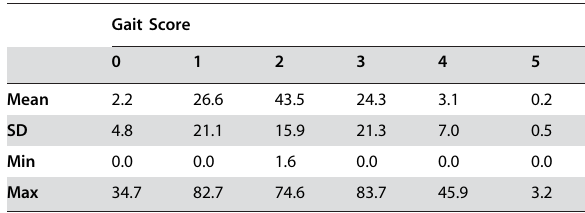
Table 1. The estimated percentage of birds in the survey